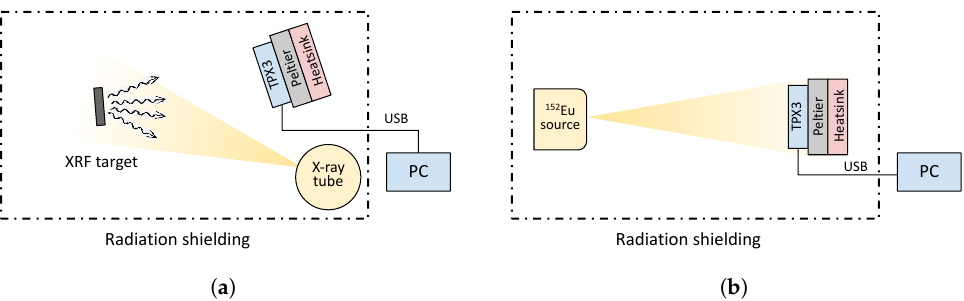
Figure 2. Schematic arrangement for measuring the energy spectrum of radiation. ( a ) X-ray fluores- cence; ( b )